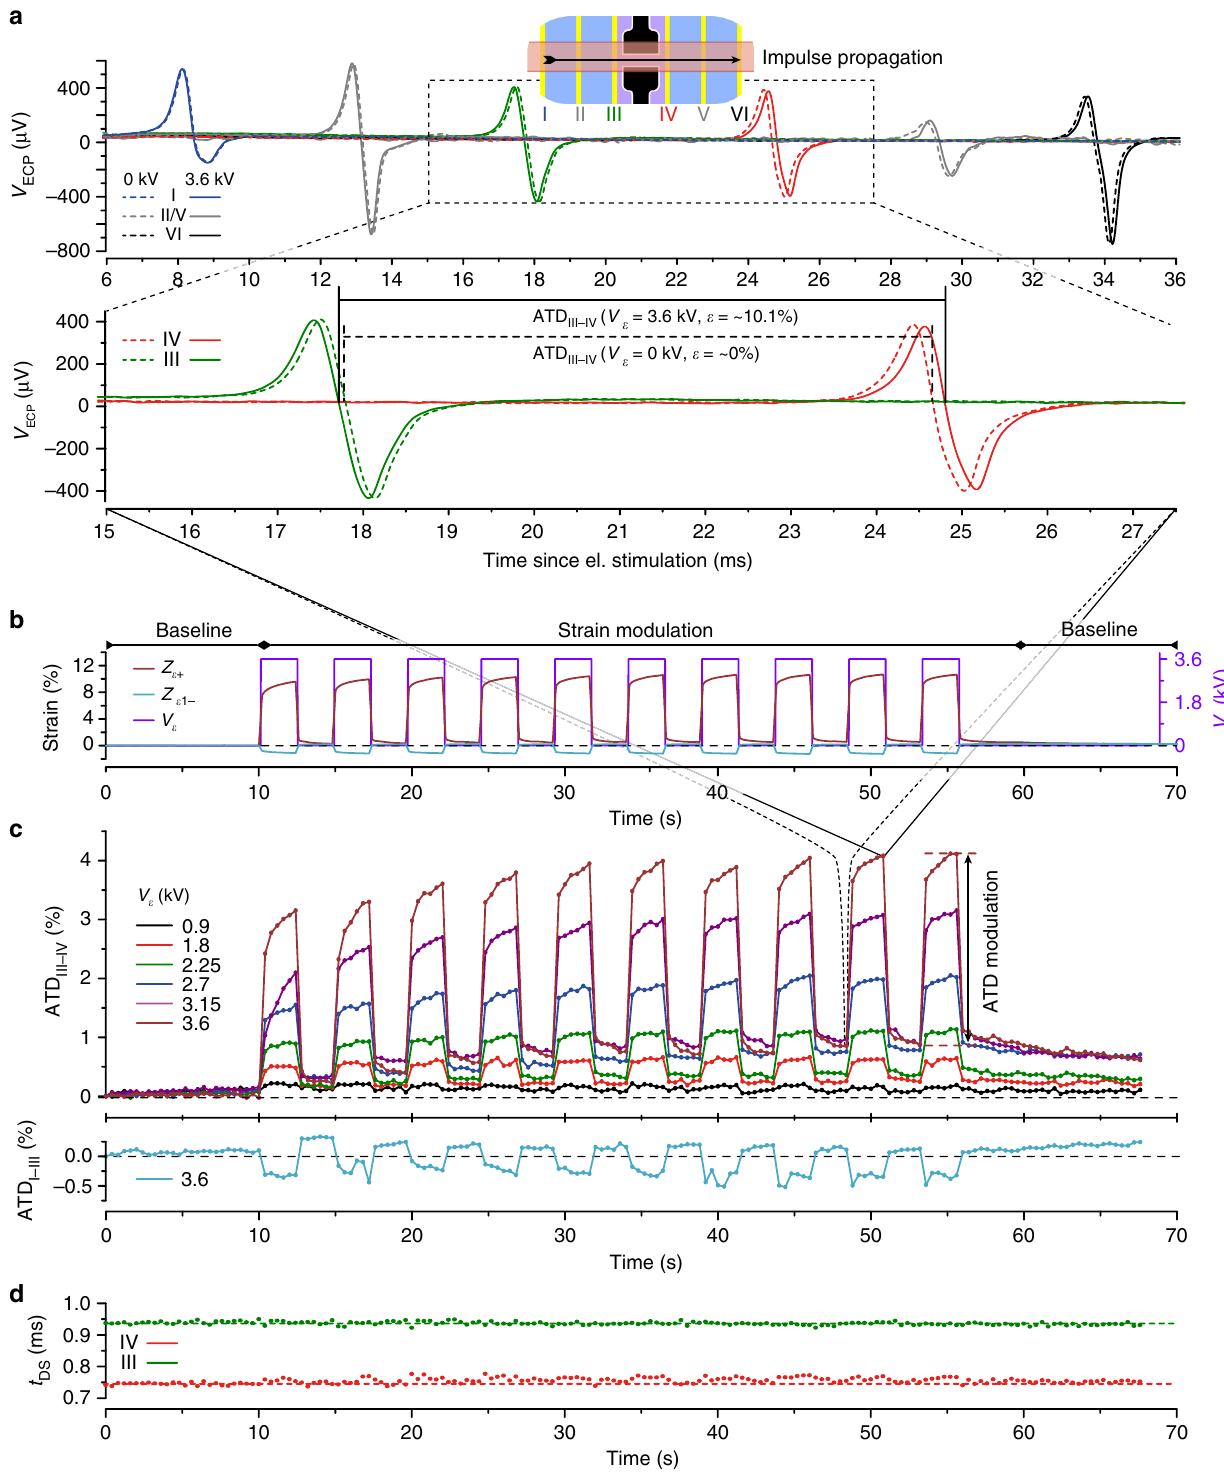
Fig. 4 Effect of strain amplitude on impulse conduction. a Upper panel: AP ECs recorded by electrodes I to VI during action potential propagation from left to right under control (dashed line) and strained conditions (solid line). Lower panel: Magni fi ed view of the signals recorded by electrodes III and IV that straddle the positive strain zone show an increase of the activation time difference (ATD) by 2.7% during application of 10.1% strain. b Experimental strain protocol depicting the actuation voltages for the DEA (black) together with the measured response of the polydimethylsiloxane (PDMS) substrate in the positive (dark red) and negative strain (light blue) zones. c Modulation of ATD in the Z ε + region for different strain amplitudes ( V ε = 1 – 4 kV according to color scheme); ATD decrease in the Z ε − region is shown for V ε = 3.6 kV only (light blue). d Continuous determinations of downstroke times ( t DS ) as recorded by electrodes III and IV at maximal strain amplitude ( V ε = 4 kV). All data were obtained from a single